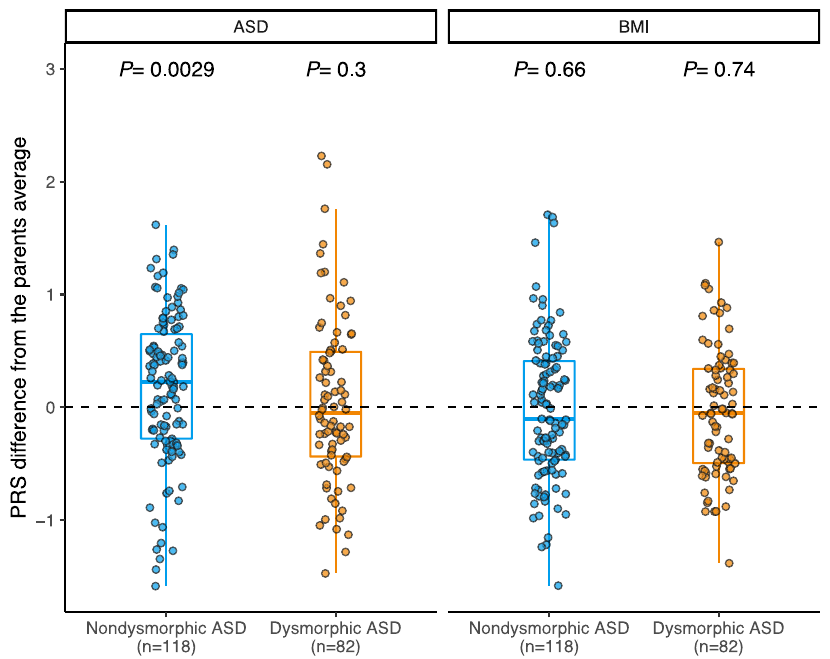
Fig.4|InheritanceofpolygenicriskforASDandBMIinmorphologicsubtypes. Differencesinpolygenicriskscore(PRS)forASDandBMIbetweenparticipantsand their respective mid-parent score. Box plots depict the median and quartiles of polygenic transmission disequilibrium test (pTDT) deviation, and the minima and maxima of box plots indicate 3× the interquartile range-deviated pTDT deviations